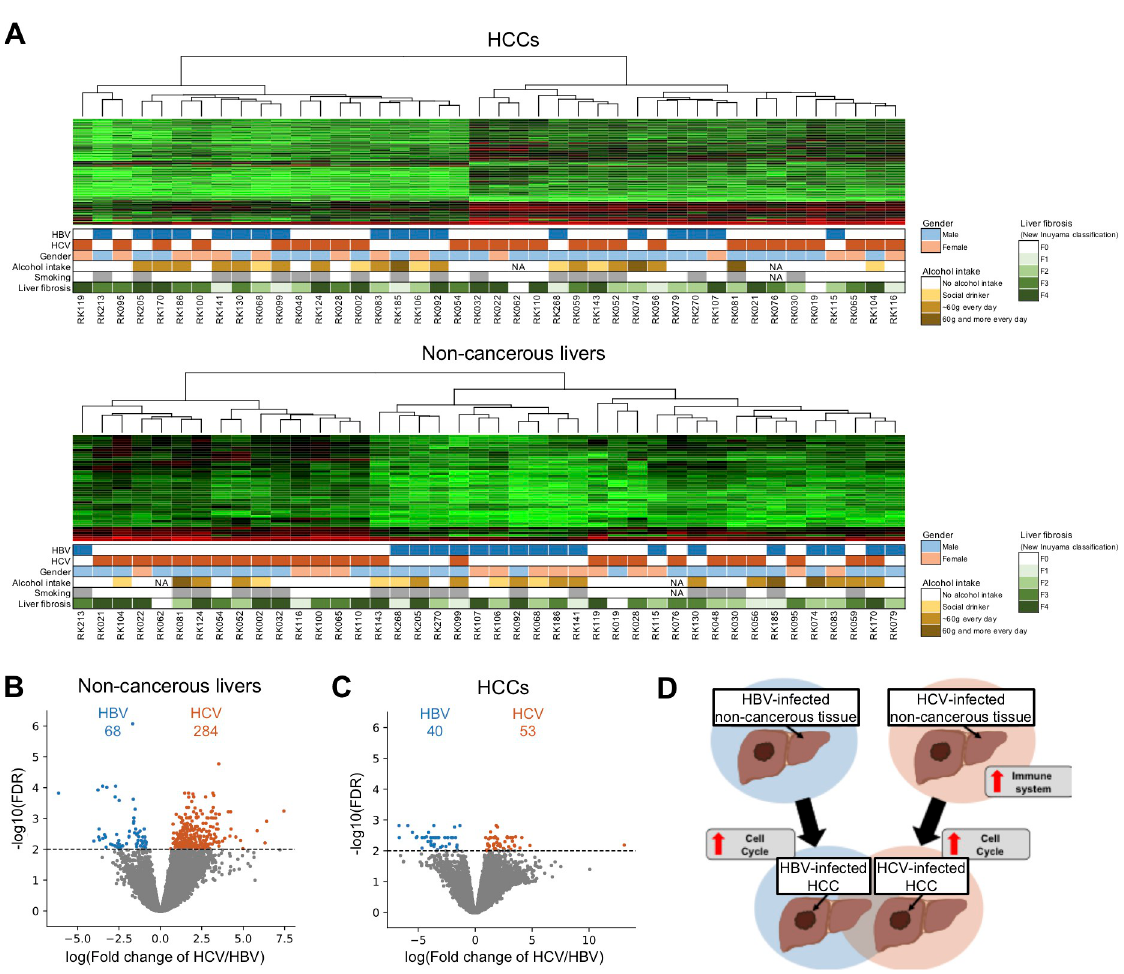
Fig 6. Comparison of expression profiles of HBV- and HCV-infected HCCs. ( A ) Clustering by the transcriptome of 16 HBV-infected tissues, 24 HBV-infected tissues, and 2 dually infected tissues in HCCs (upper) and in matched non-cancerous livers (lower). Clinical and pathological information of the samples is shown in the lower panels. ( B, C ) Volcano plots of DETs in HBV- and HCV-infected tissues. Light blue and orange dots represent transcripts that were significantly up-regulated in HBV- and HCV-infected tissues with FDR < 0.01. ( B ) Comparison in non-cancerous liver samples. ( C ) Comparison in HCC samples. ( D ) Schematic diagram of the expression profiles of HBV- and HCV-infected tissues.